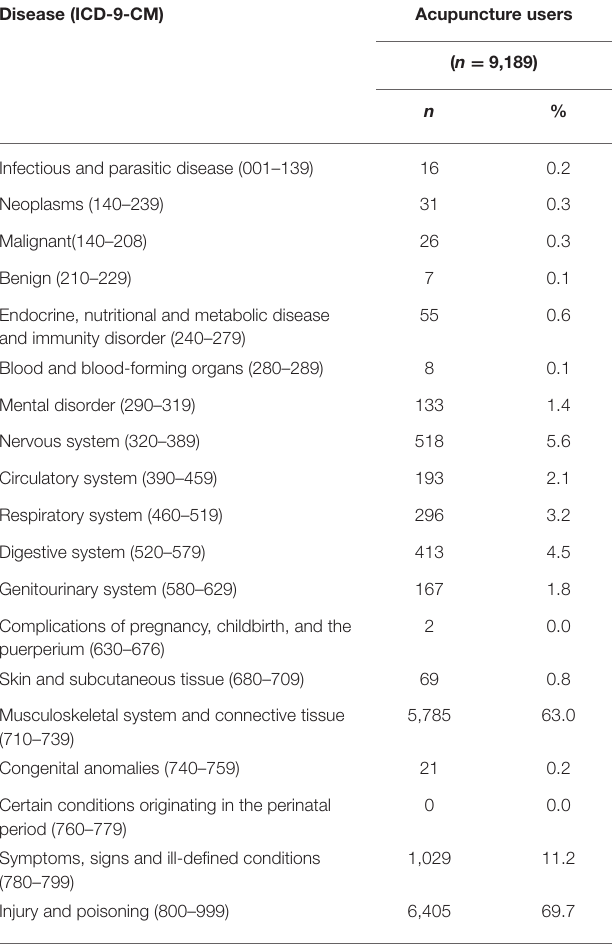
TABLE 2 | Acupuncture cohort stratified by disease categories/diagnoses of patients with depression. Disease (ICD-9-CM)